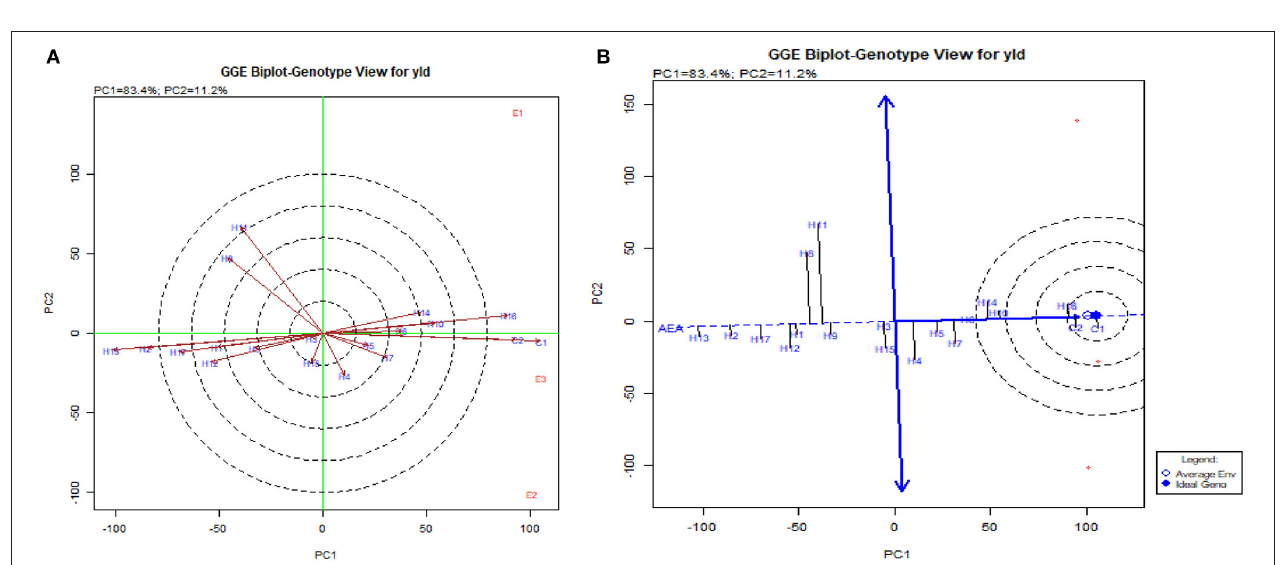
FIGURE 9 | GGE biplot for single plant yield in hybrids. (A) The genotype view of the hybrids for single plant yield in the GGE plot. (B) The ideal genotype plot of hybrids for single plant yield in the GGE biplot.